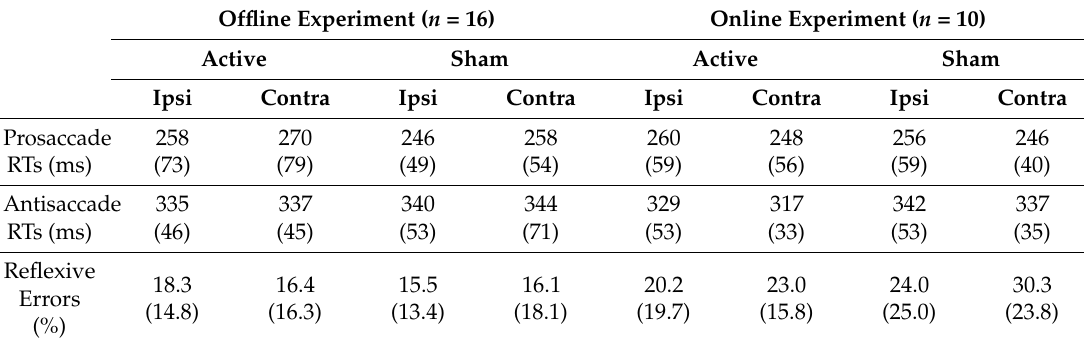
Table 1. Saccade latencies (in milliseconds) and reflexive errors (in percentage) following active versus sham stimulation in each